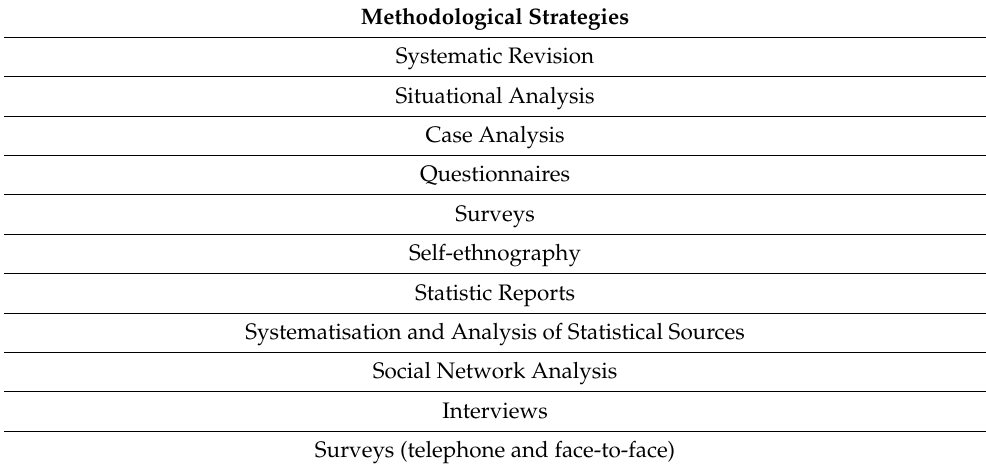
Table 2. Methodological strategies used in the selected articles. Source: own